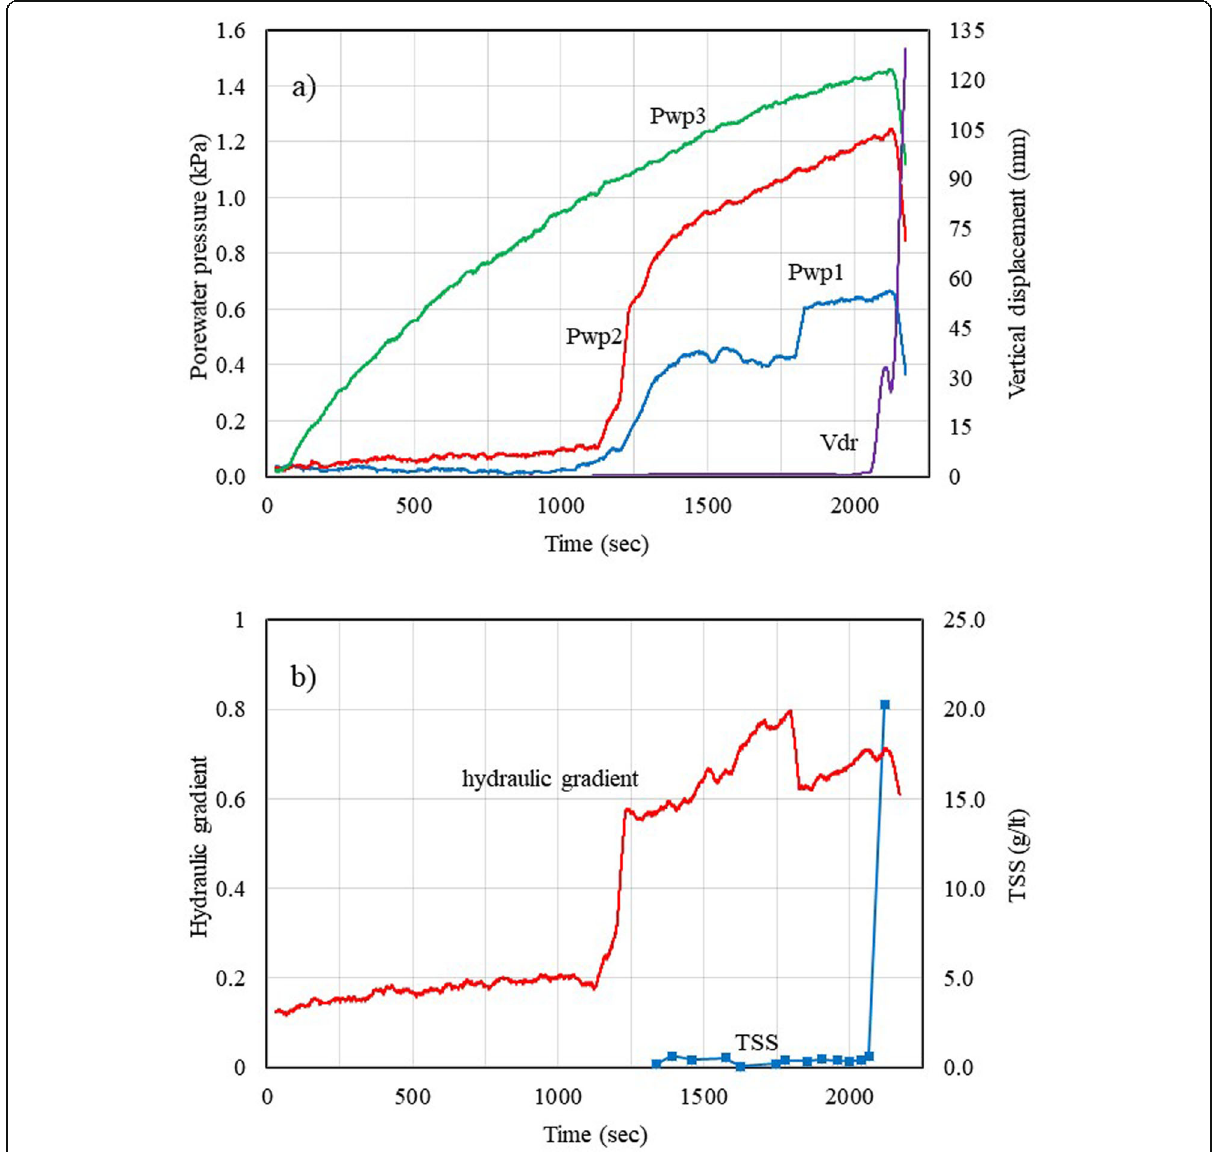
Fig. 5 Experiment results of experiment No. EXP 4F of GII sample. a Pore water pressure and vertical displacement b Hydraulic gradient and